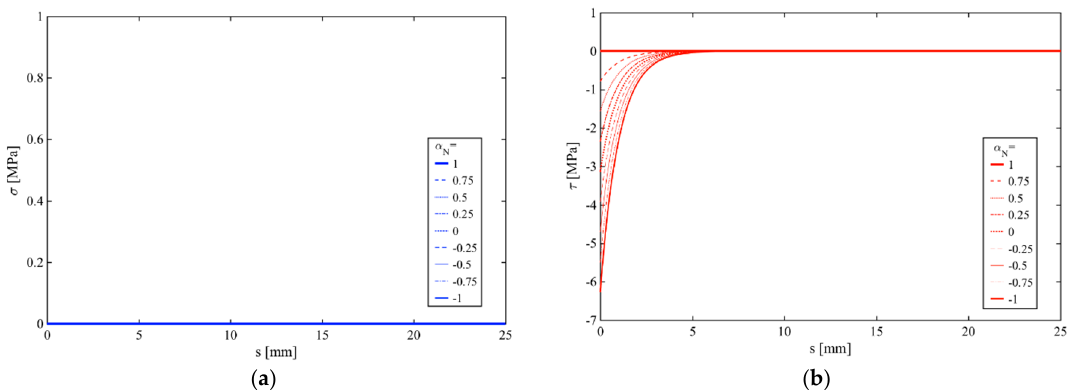
Figure 3. Effect of the axial loading on the interface local response: ( a ) Normal stress; ( b ) Tangential stress. (Isotropic specimen).